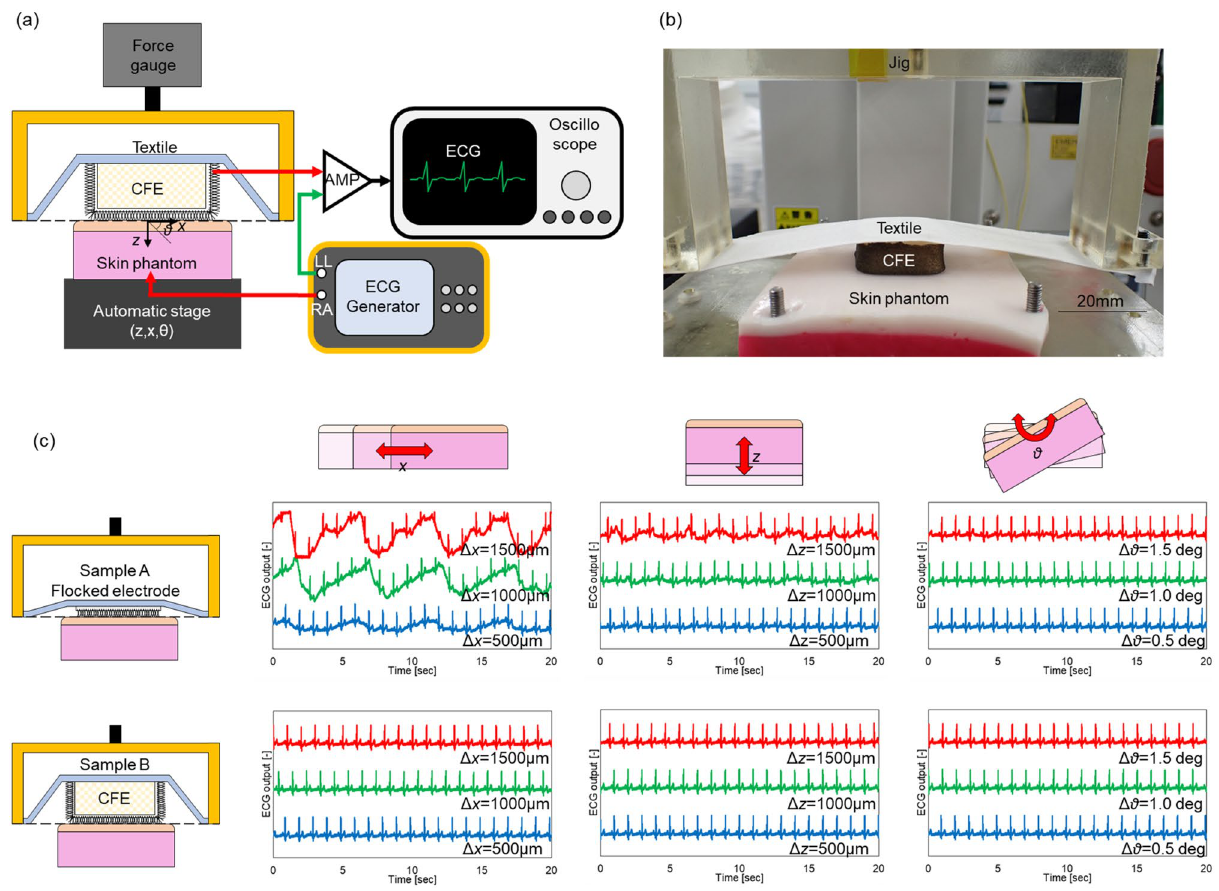
Figure 2. MA evaluation when measuring ECG using a skin phantom. ( a ) Experimental setup of MA evaluation equipment, and ( b ) photograph of contact part. ( c ) Experimental results of the MA evaluation experiments when the automatic stage displaced the x -axis (Δ x = 500 µm, 1000 µm, 1500 µm), the z -axis (Δ z = 500 µm, 1000 µm, 1500 µm), and the θ -axis (Δ θ = 0.5°, 1.0°, 1.5°). Sample A is the textile on which the flocked electrode was formed directly. Sample B is the CFE, which was attached to the textile.